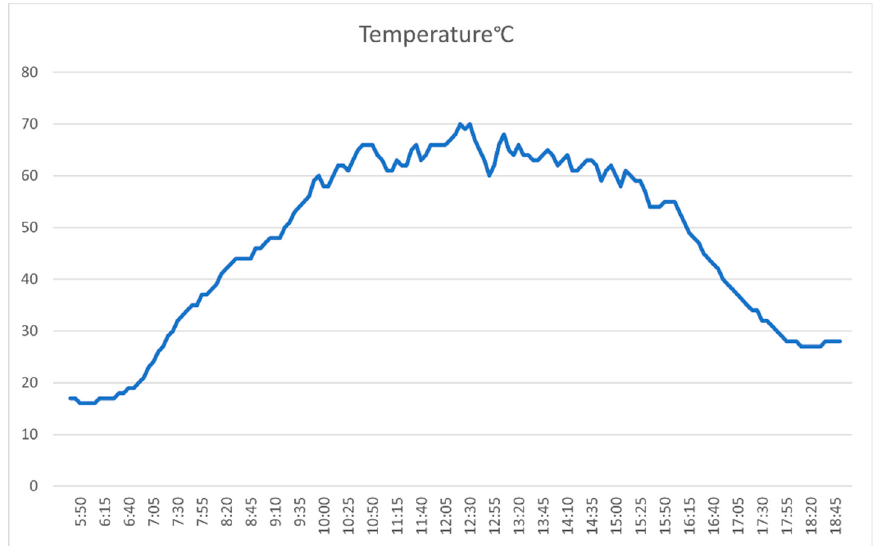
Figure 13. Temperature in the solar panels of the case study for day 27 August 2019.